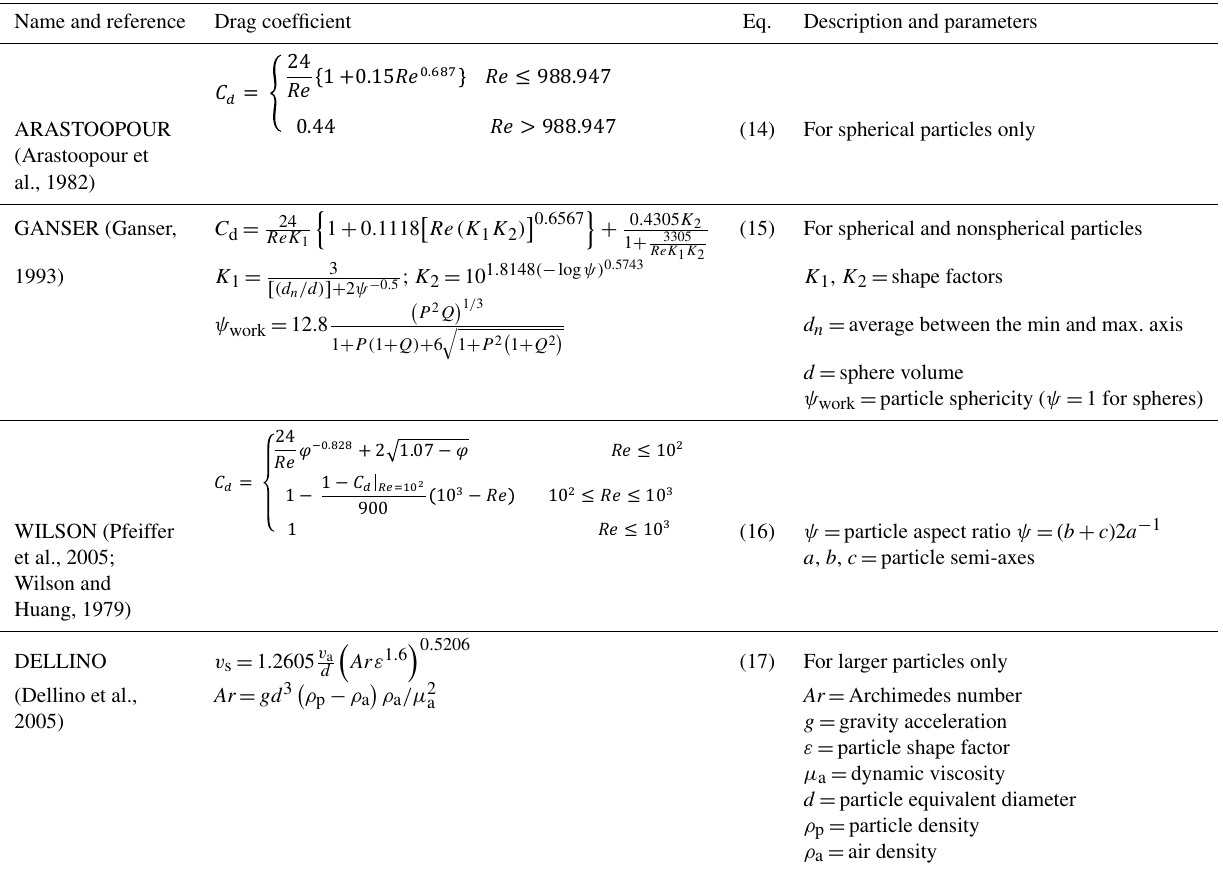
Table 6. Settling velocity models in NMMB-MONARCH-ASH.